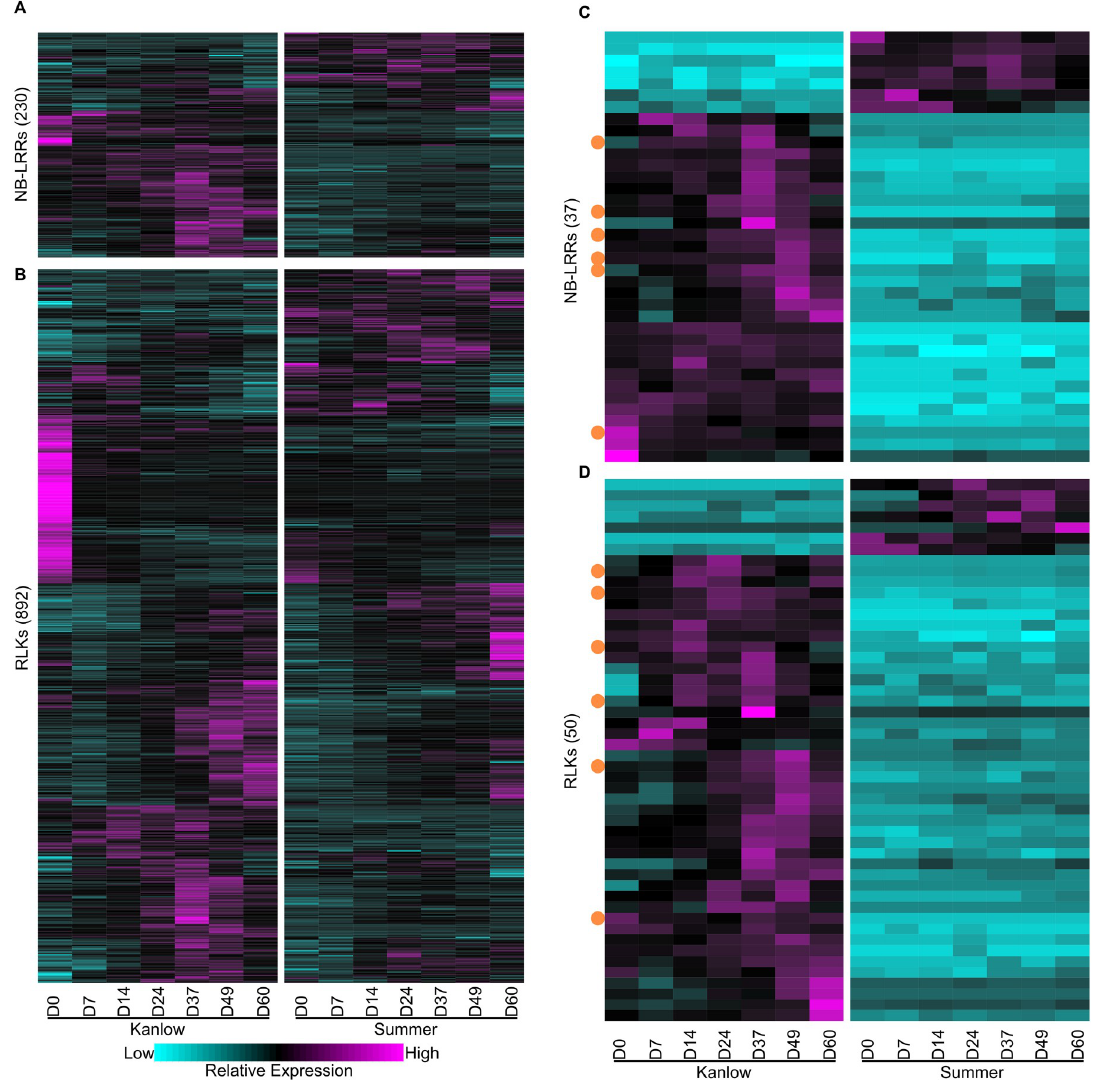
Fig 6. Expression profiles of potential defense-related genes. (A) Nucleotide-binding leucine-rich repeat (NB-LRRs) (B) Receptor-like kinases (RLKs), (C) NB-LRRs unique to or significantly more (log 2 -fold change � 3) abundant in one or the other cultivar, (D) RLKs unique to or significantly more (log 2 -fold change � 3) abundant in one or the other cultivar. For heat maps, one way clustering was performed and the dendrograms removed for ease of presentation Expression profiles are shown as z-scores with magenta = high expression and cyan = low/no expression. Orange dots in (C) and (D) indicate genes potentially not found in the Summer genome (‘upland absent’).